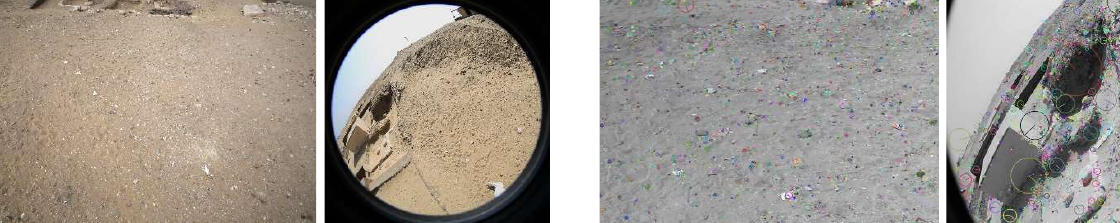
Figure 3. FOV of the 20mm lens from a height of 3m (left) Figure 4. Key points computed with SIFT (Scale Invariant compared with FOV of the 8mm fisheye lens from a height of Feature Transform) in OpenCV. Zoomed portions of the images 2m (right). in Figure 3 show the difference in scale of the key